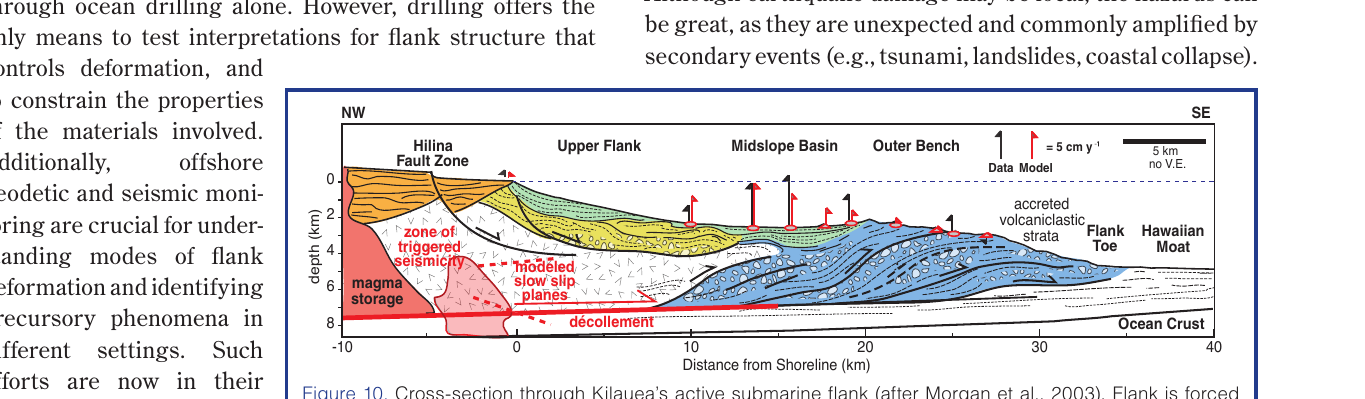
Figure 10. Cross-section through Kilauea’s active submarine flank (after Morgan et al., 2003). Flank is forced seaward by gravitational spreading, resulting in frontal sediment accretion and bench uplift. Aseismic slip along the active décollement (in red) can account for vertical displacement recently measured along the distal flank (data from Phillips et al., 2008). Aseismic slip may be accommodated in part by repeated slow earthquakes, which are modeled to occur at or near the décollement plane and are associated with triggered microseismicity (after Brooks et al.,